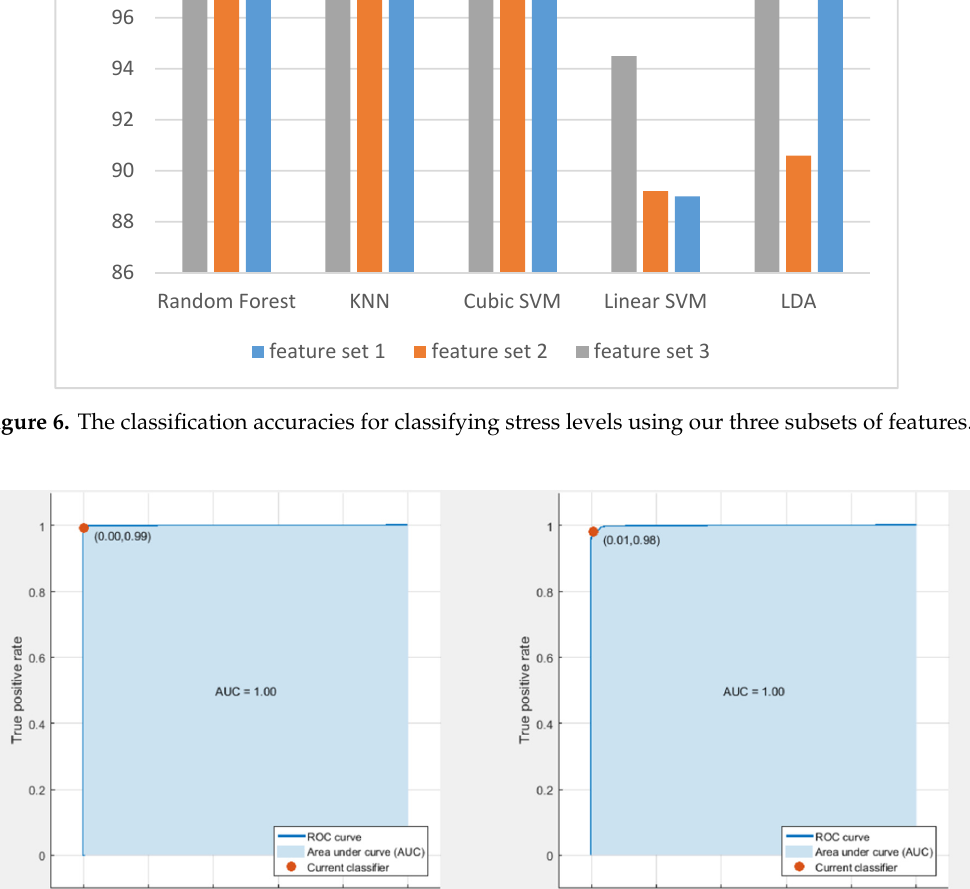
Figure 7. ROC curve for evaluating stress levels; ( a ) cubic SVM classifier, ( b ) KNN classifier .